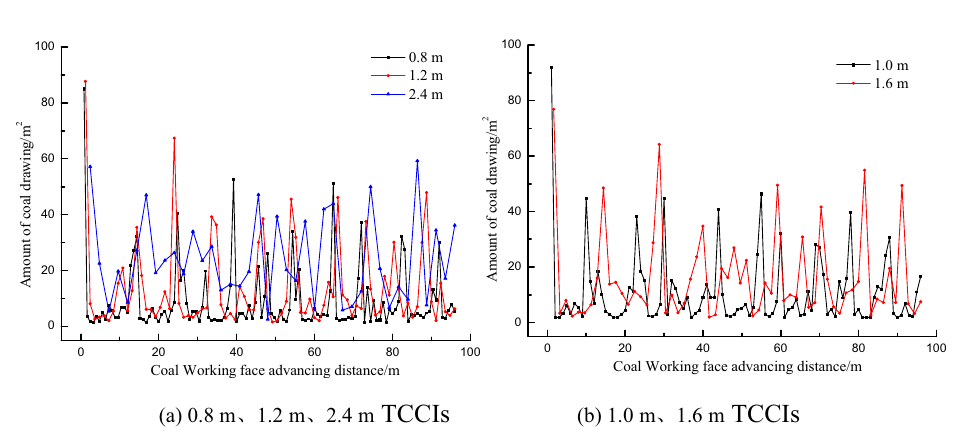
Figure 10. Statistics of top coal recovery amount of each step in different coal-drawing interval under 12.0 m top coal thickness.